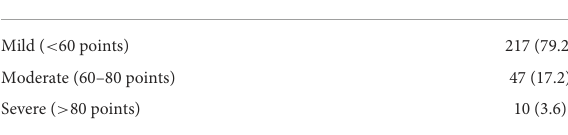
TABLE 3 Quality of life in ADHD children ( n =